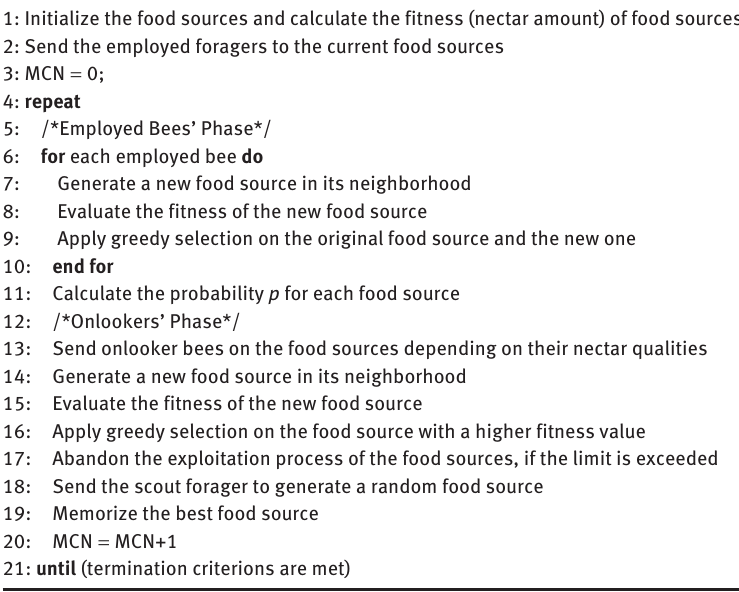
Algorithm 1: Schematic Pseudocode of the ABC